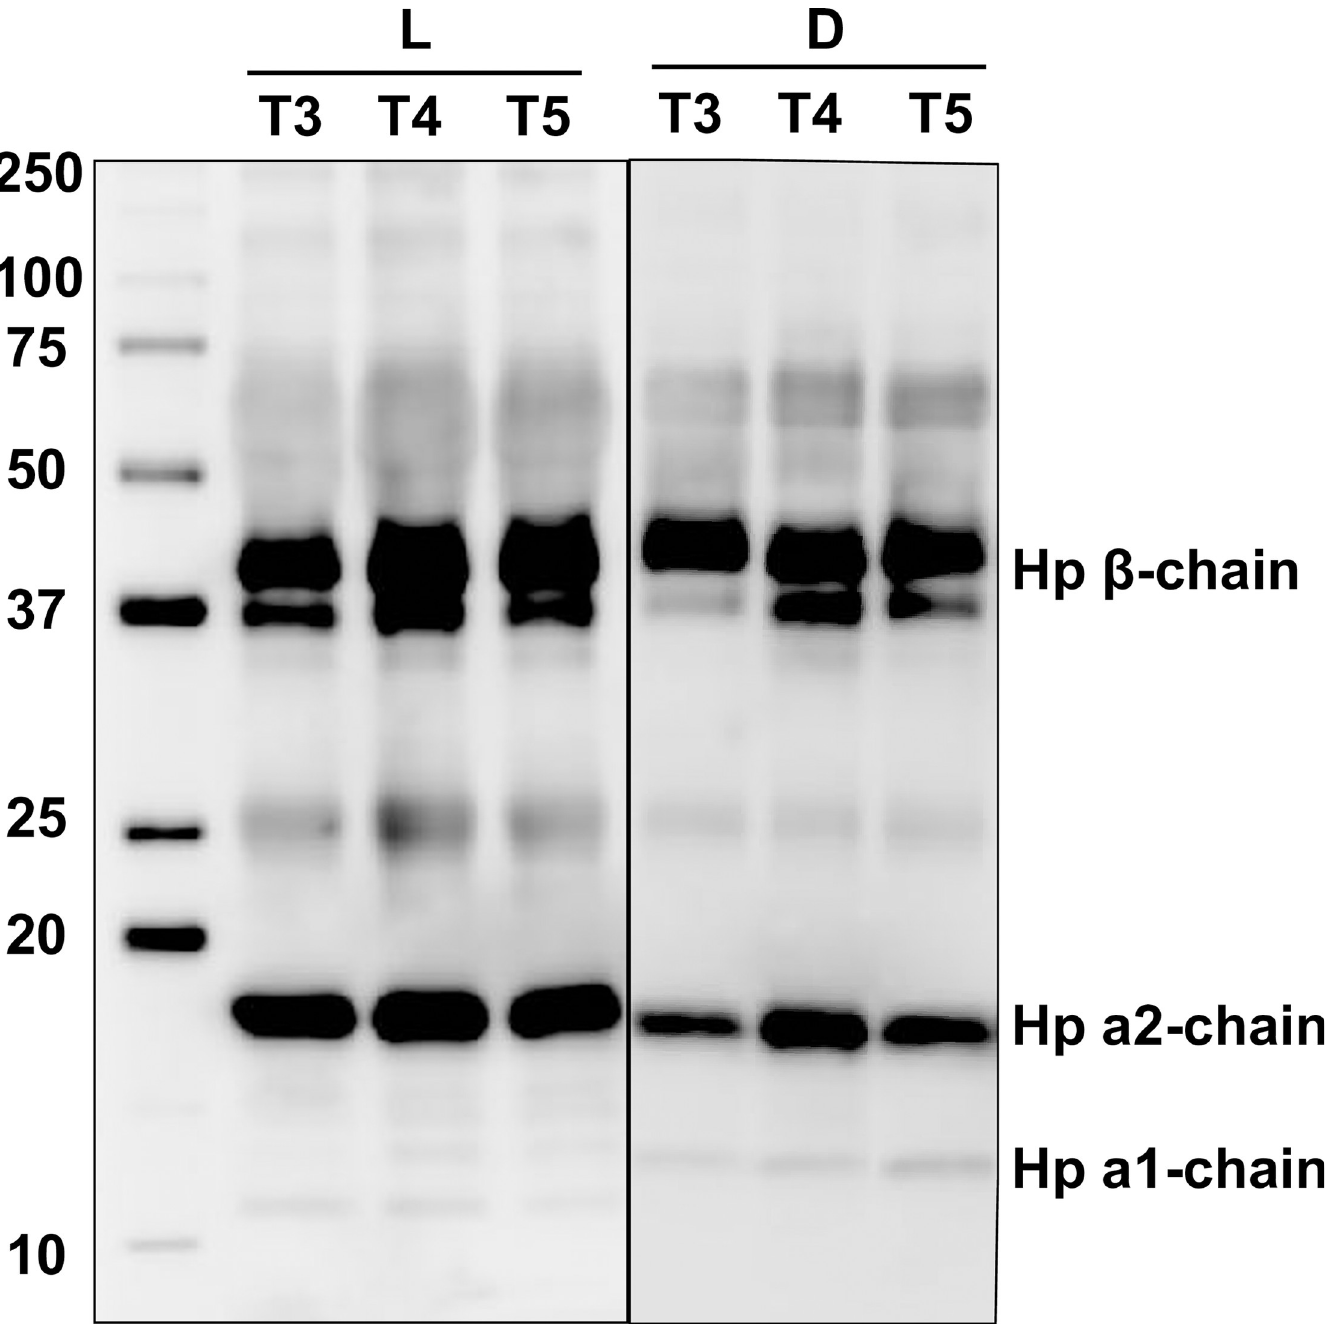
Fig 10. Detection of complement factor B protein in the surviving group (L) and adverse outcome group (D) by means of Western blotting. Two time points of each group were compared to confirm the overall change over time ( t 1 ! t 5 ).